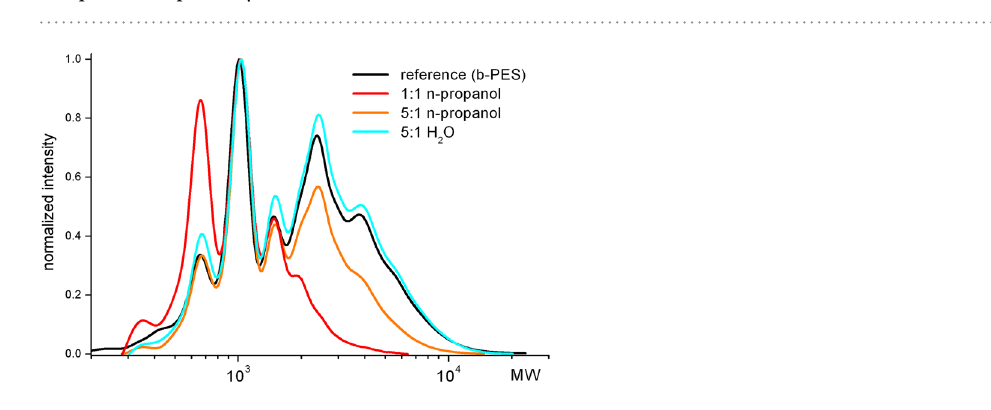
Figure 9. Normalized SEC curves of supernatants obtained from LDH-BA with b-PES (reference, black) in neat water (light blue) and in n-propanol for two charge ratios.